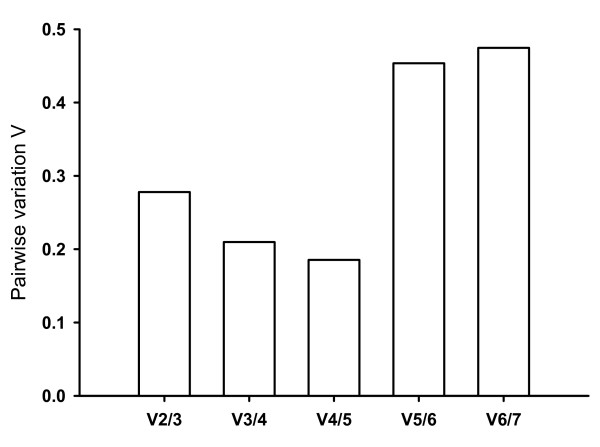
Pair wise variation of sequential normalisation factors (Vn/n+1) in the kairomone experiment estimated by geNorm. V2/3 is based on the geometric mean of the normalisation factors of GapDH, TBP and SucDH; V3/4 is V2/3 and cyclophilin; V4/5 is V3/4 and UBC; V5/6 is V4/5 and 28S; V6/7 is V5/6 and 18S.